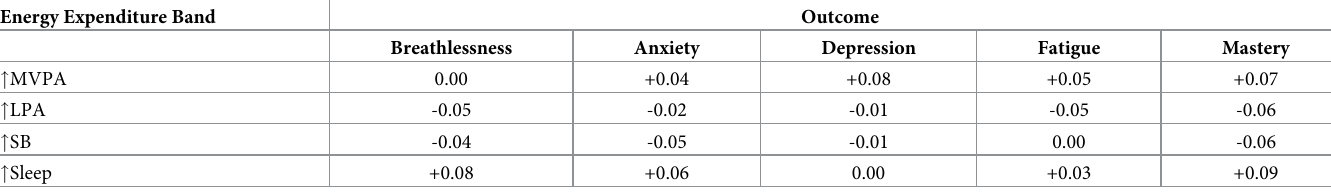
Table 4. Association with change in outcomes when 30 minutes of time was re-allocated to each energy expenditure band (when drawing time pro rata from the remainder of the energy expenditure bands in the composition). Energy Expenditure